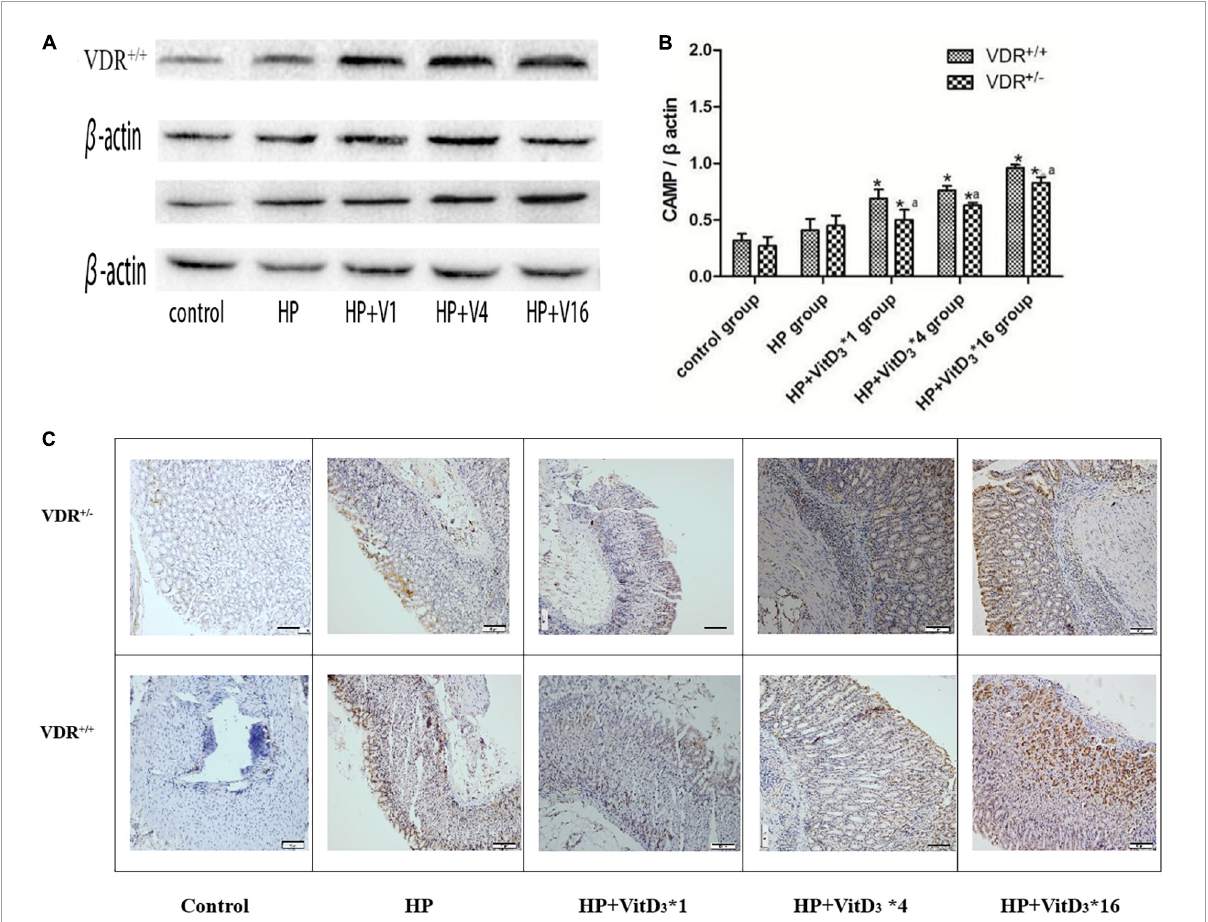
FIGURE6 VitD 3 upregulated cathelicidin antimicrobial peptide (CAMP) expression in the mouse gastric mucosa. (A) CAMP expression in the gastric mucosa was analyzed by western blotting. VitD 3 gavage increased CAMP protein expression in a dose-dependent manner. The CAMP expression level was consistently lower in VDR + / − than in VDR + / + mice ( n = 6; P < 0.05). (B) Histogram showing quantitative analysis of the results presented in panel (A) . (C) Immunohistochemistry analysis showing VitD 3 dose-dependent increase of CAMP staining intensity in the mouse mucosa. * P < 0.05 vs. HP group and a P < 0.05 vs. VDR + / + group. HP, Helicobacter pylori infection. Scale bar = 50 µ